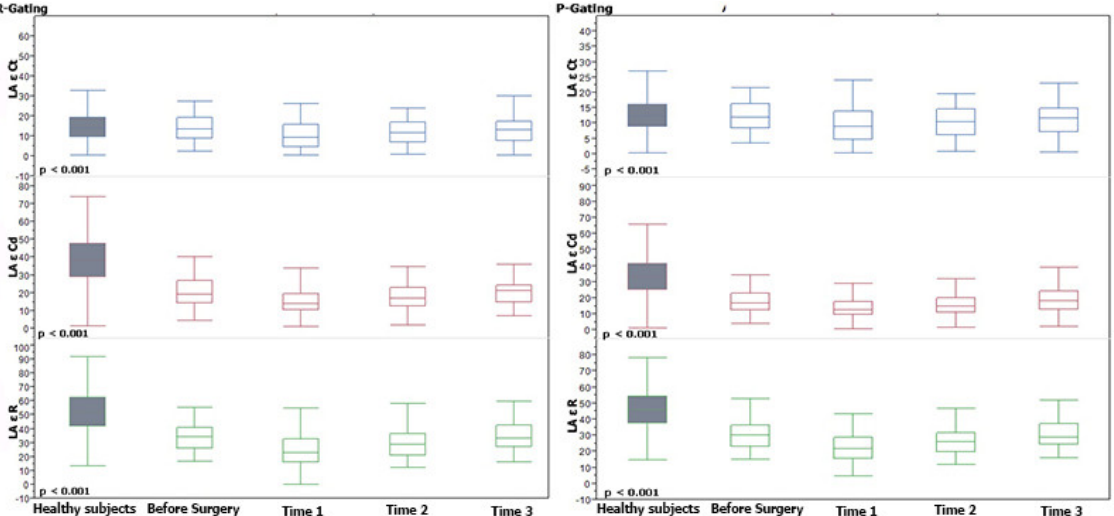
Figure 3. Left Atrial Strain trends at different pre-/post-operative times and in comparison to the control group. Median and interquartile range of ε values over time are shown. p values in the patient group were determined relative to strain from Time 1 to Time 3. Horizontal line = median; Box = interquartile range.